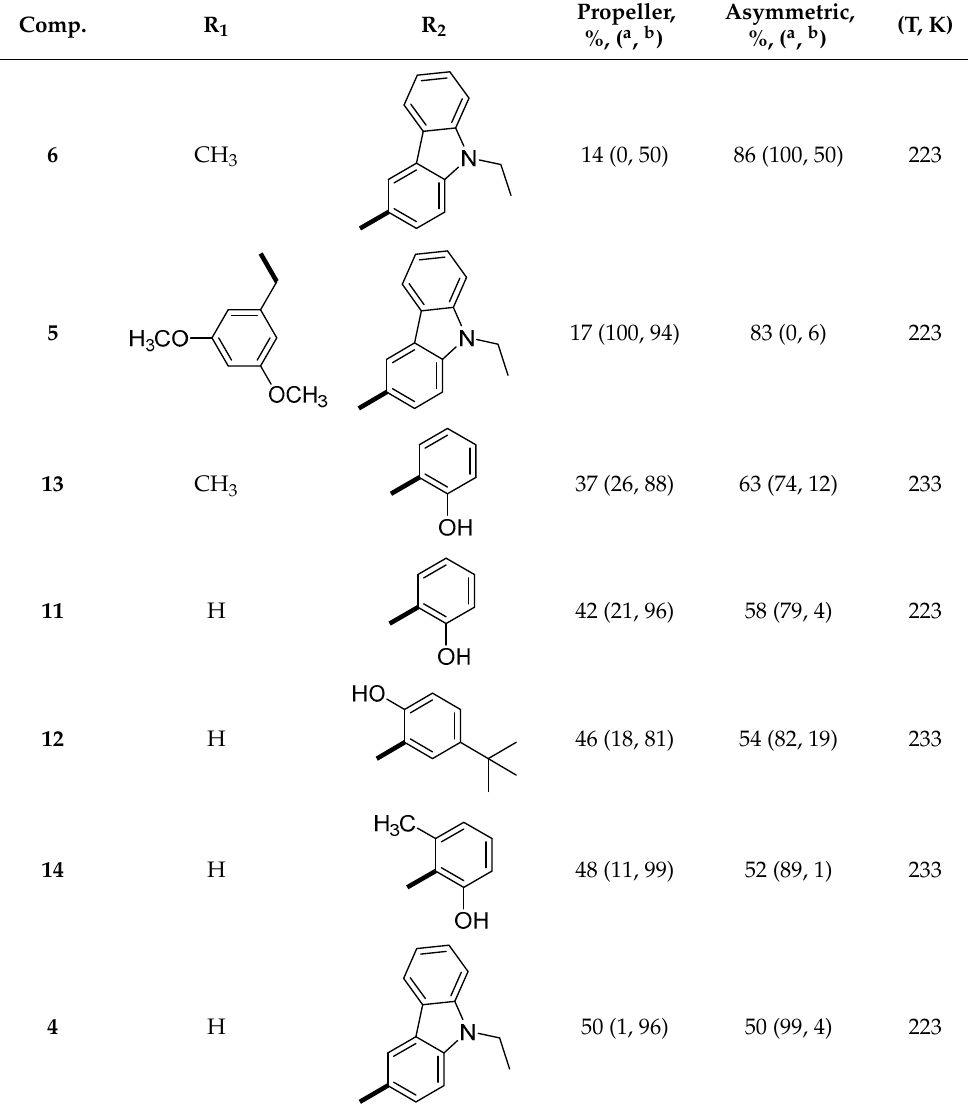
Table 2. Populations of propeller and asymmetric conformers in DMF-d7 of studied compounds. Comp.